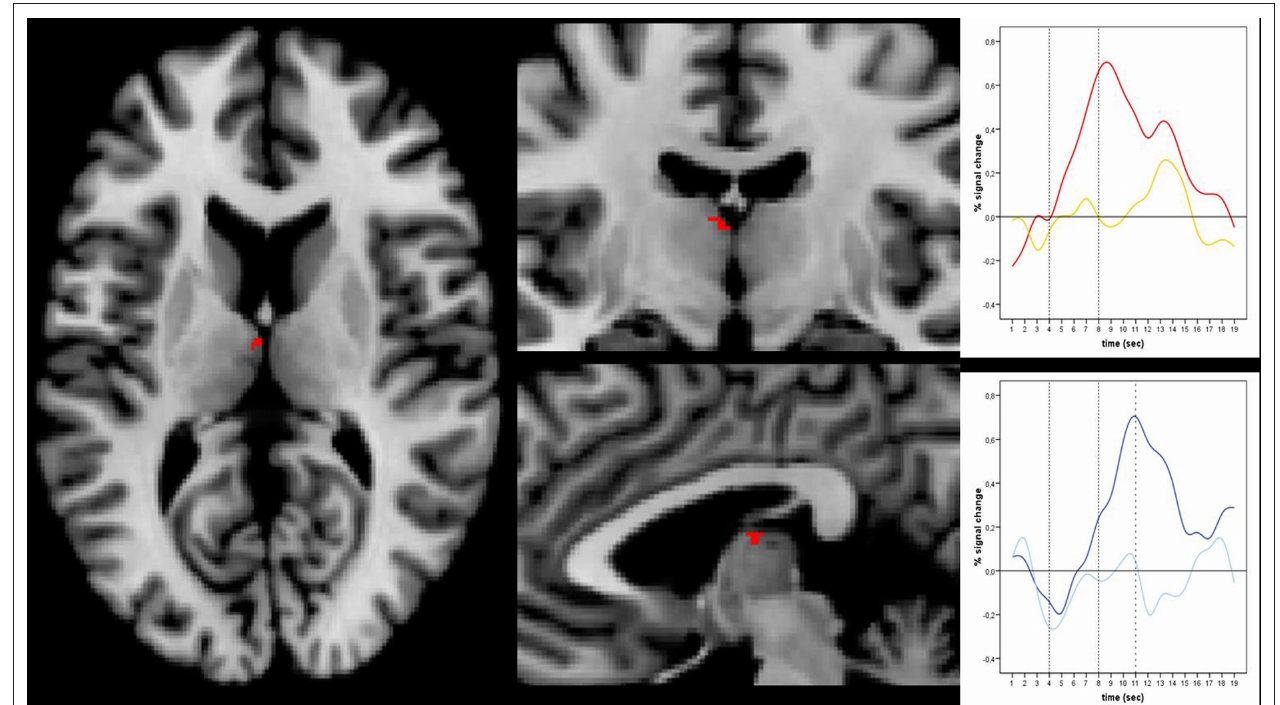
separately in the upper picture for erotic (red) and emotional picture perception (yellow) and in the lower picture for erotic (dark blue) and emotional anticipation (light blue). Peaks for erotic expectancy conditions lagged those of the erotic picture conditions by 3 s, which was the actual lag of expectancy and subsequent picture conditions. This indicates at least a confound on the expectancy effects by their subsequent picture